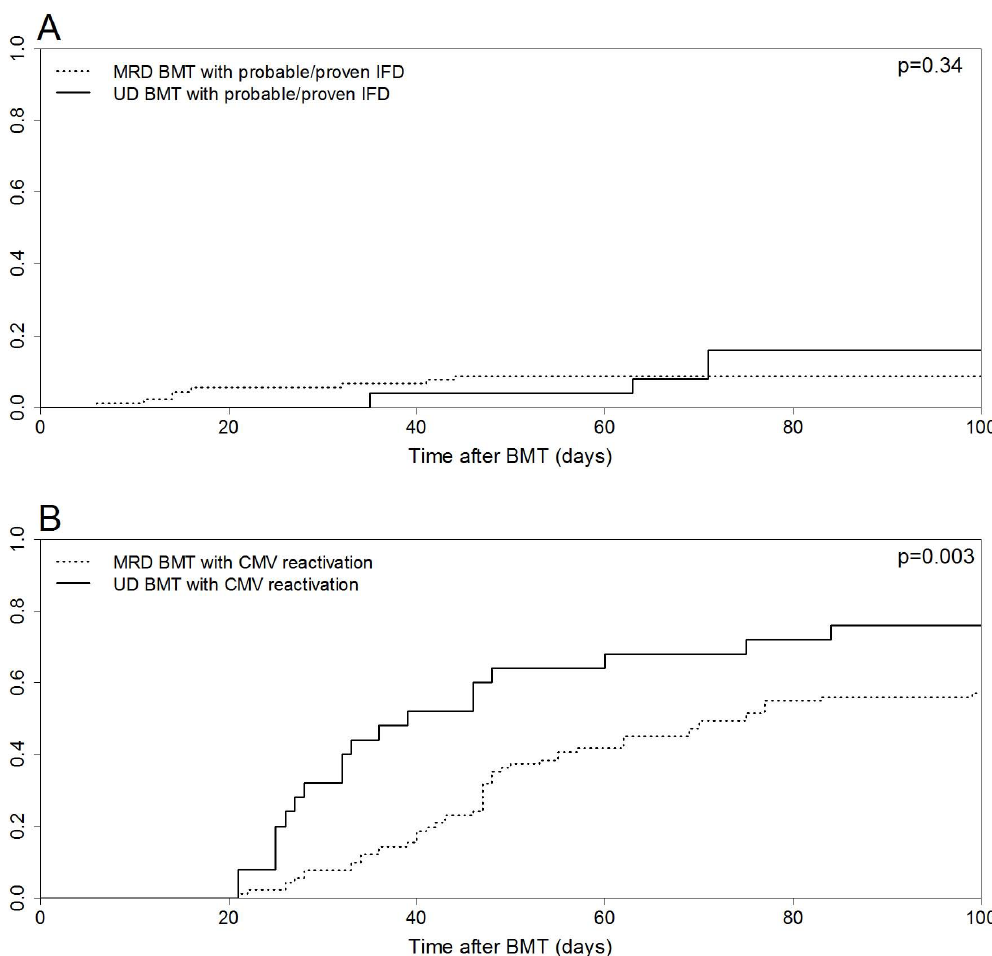
Figure 2. Cumulative incidence curves for matched related donor (MRD) and unrelated donor (UD) bone marrow transplantation (BMT). (A) Day + 100 probability for proven or probable invasive fungal disease (IFD). (B) Day + 100 probability for cytomegalovirus (CMV) reactivation.